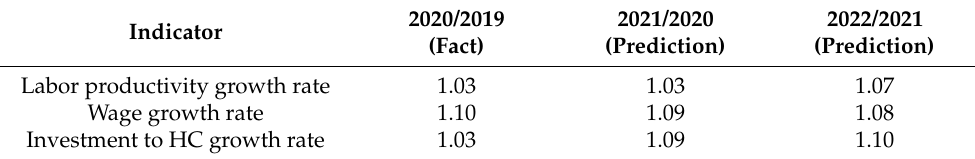
Table 9. Growth rates for labor productivity, wages and human capital